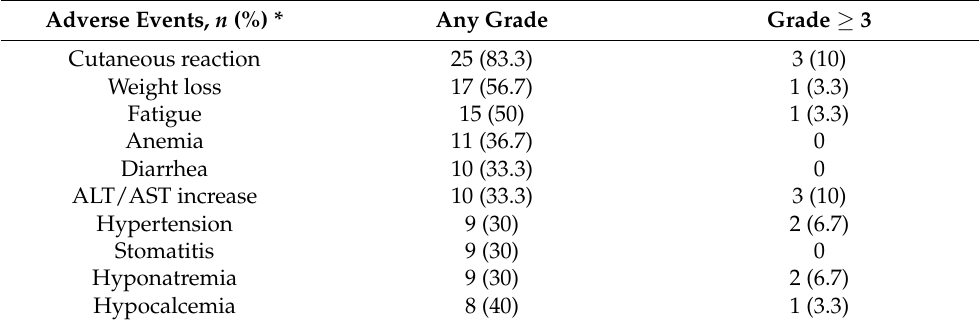
Table 2. Adverse effects of Sorafenib for ATC patients